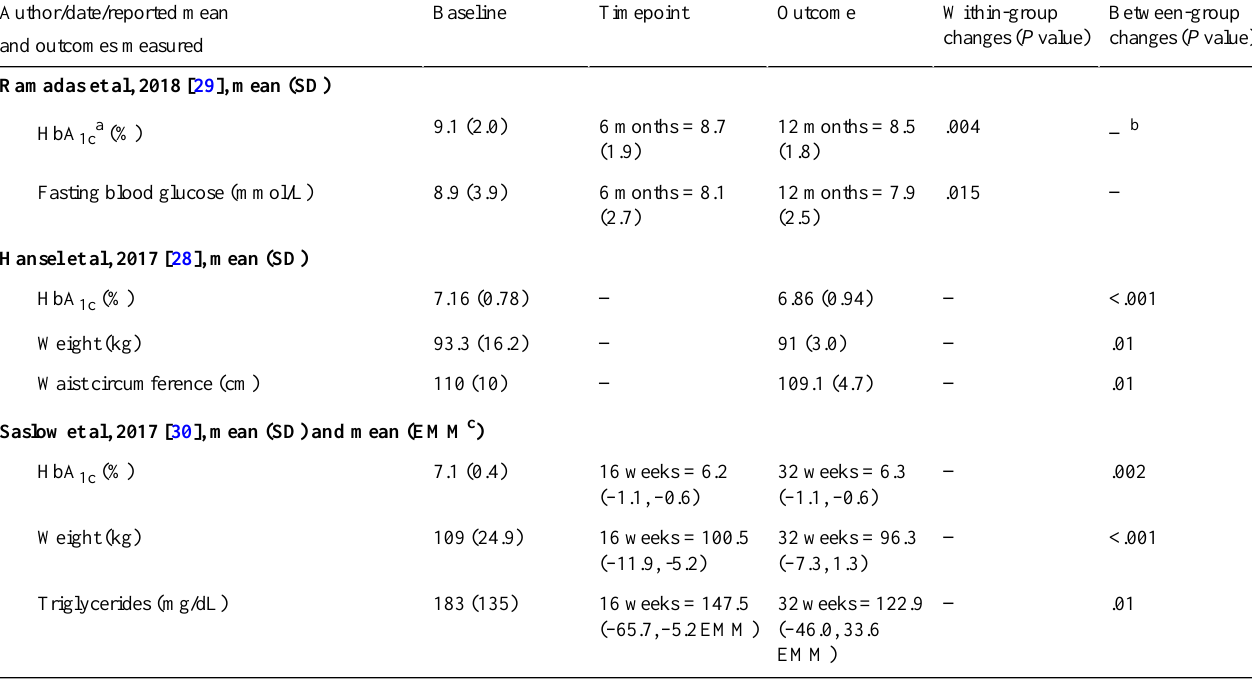
Table 3. Significant clinical outcomes for dietary intervention groups. Data were considered statistically significant if P <.05.